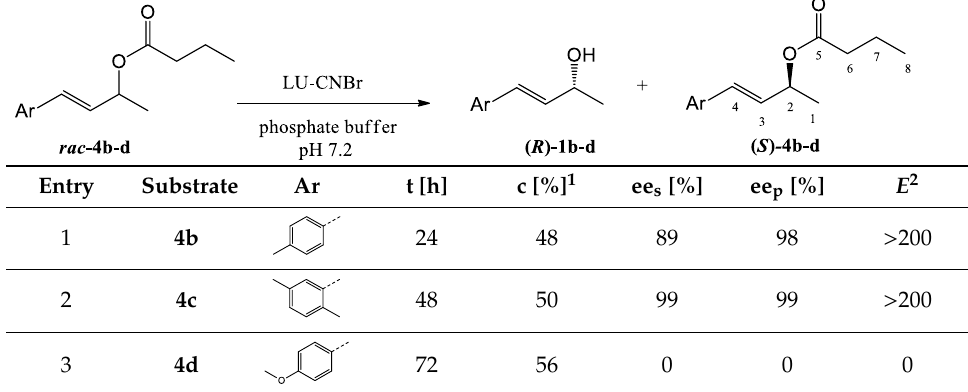
Table 4. Hydrolysis of butyrates 4b–d with different substituents on a benzene ring catalyzed by